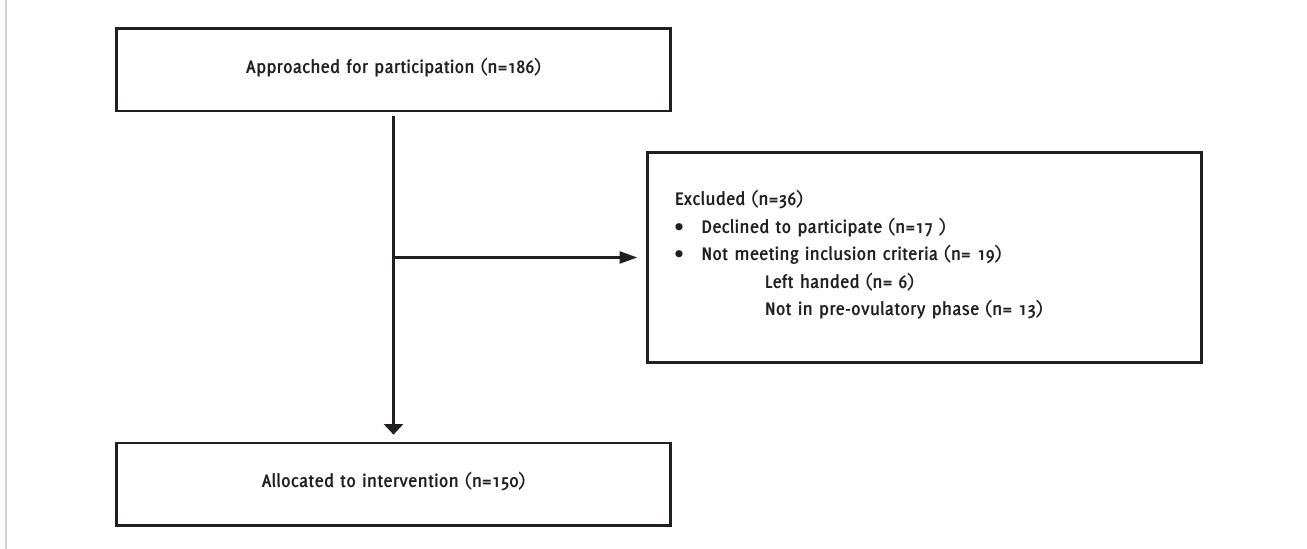
Figure 1 . CONSORT diagram showing selection of participants for